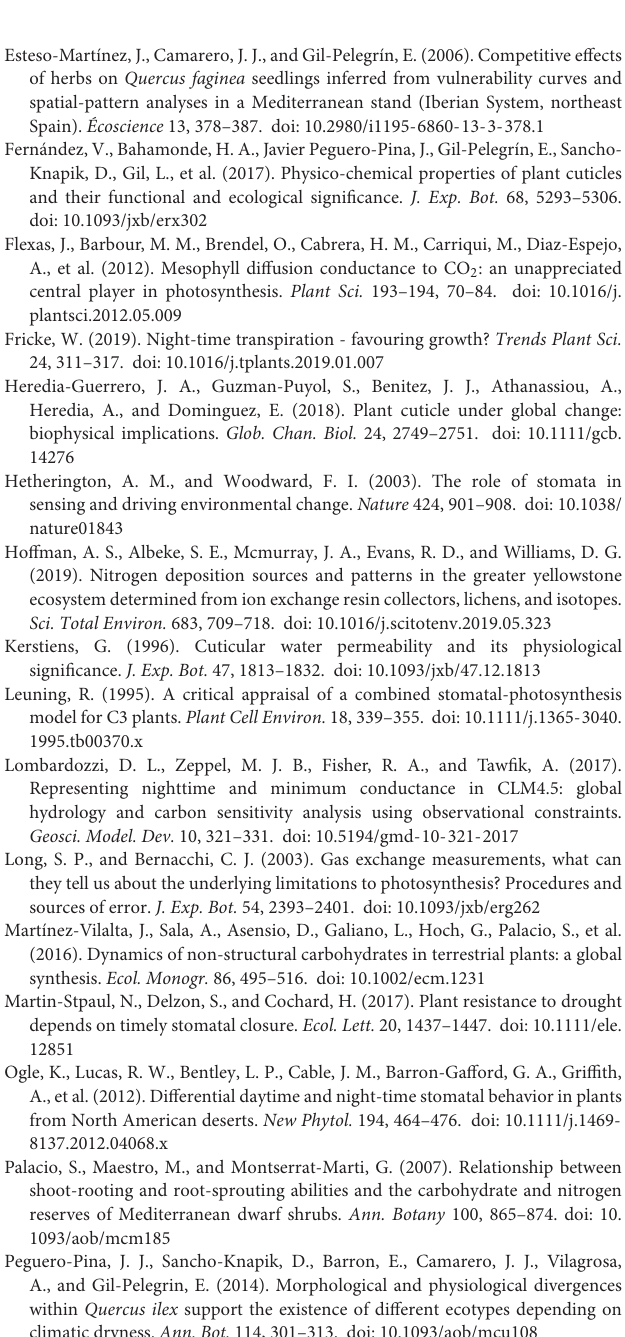
Supplementary Table 1A | Target midday water potential ( (cid:57) md ) to reach the desired PLC according to Esteso-Martínez et al. (2006) for Q. faginea and to Peguero-Pina et al. (2014) for Q. ilex , and actual values. Mean (and SE) actual values are presented. The letters in “Actual PLC” indicate the results of post